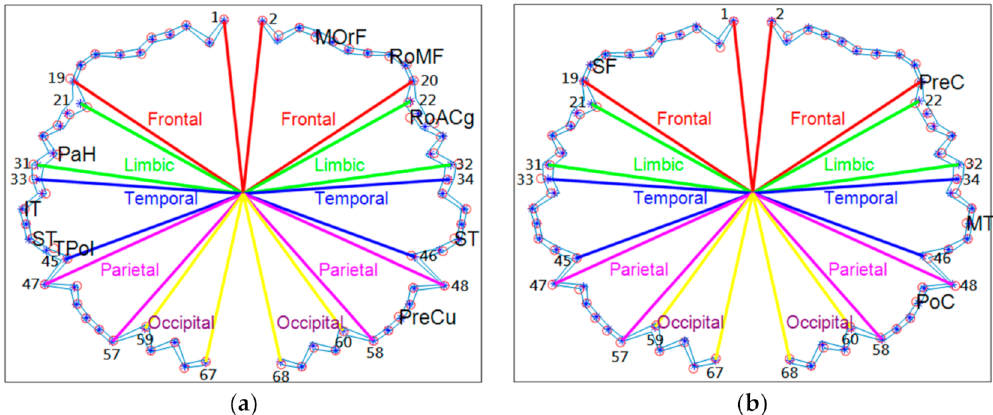
Figure 6. Pre-diagnosis system based on FD with the Desikan–Killiany atlas measuring ( a ) participant 37 from the men in the middle-age group vs. men in the middle-age group; ( b ) participant 37 from the women in the middle-age group vs. women in the middle-age group. In each figure, the blue star represents each cortical subregion in the middle-age group; the distance from the center to the blue star is the mean FD value of each cortical subregion. The red dots indicate the FD values of each subregion of one test participant. If the FD value of each subregion of the test participant was smaller than his/her peer group, the FD value of the blue star (mean FD value of the index of the identical subregion) subtracted by the standard deviation, then these significantly smaller subregions are labeled as the susceptive of abnormal